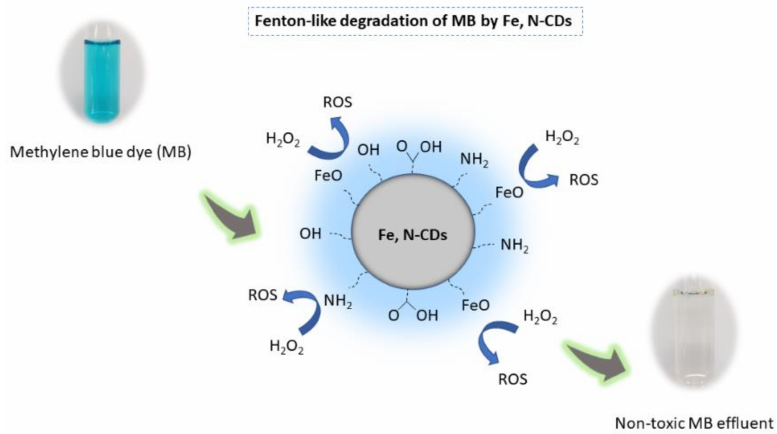
Figure 6. Illustration of the potential mechanism of CDs as Fenton-like catalysts